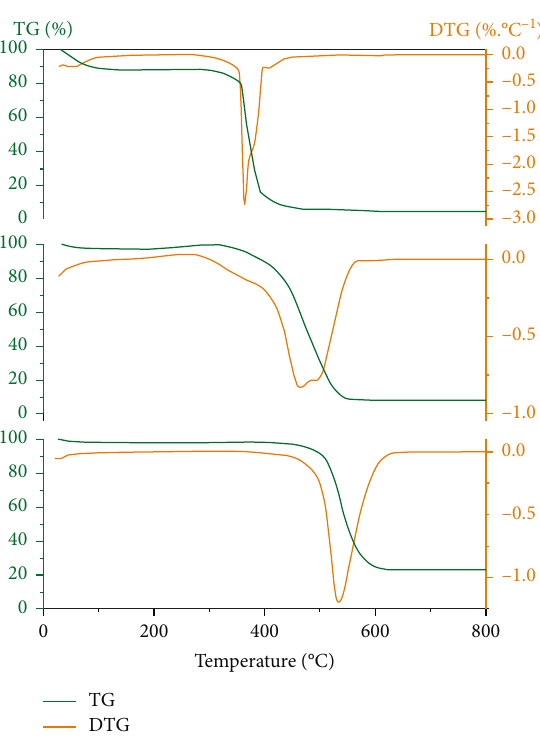
Figure 2: TG–DTG curves of the coal dust samples: (a) HM; (b) QM; (c) WY.